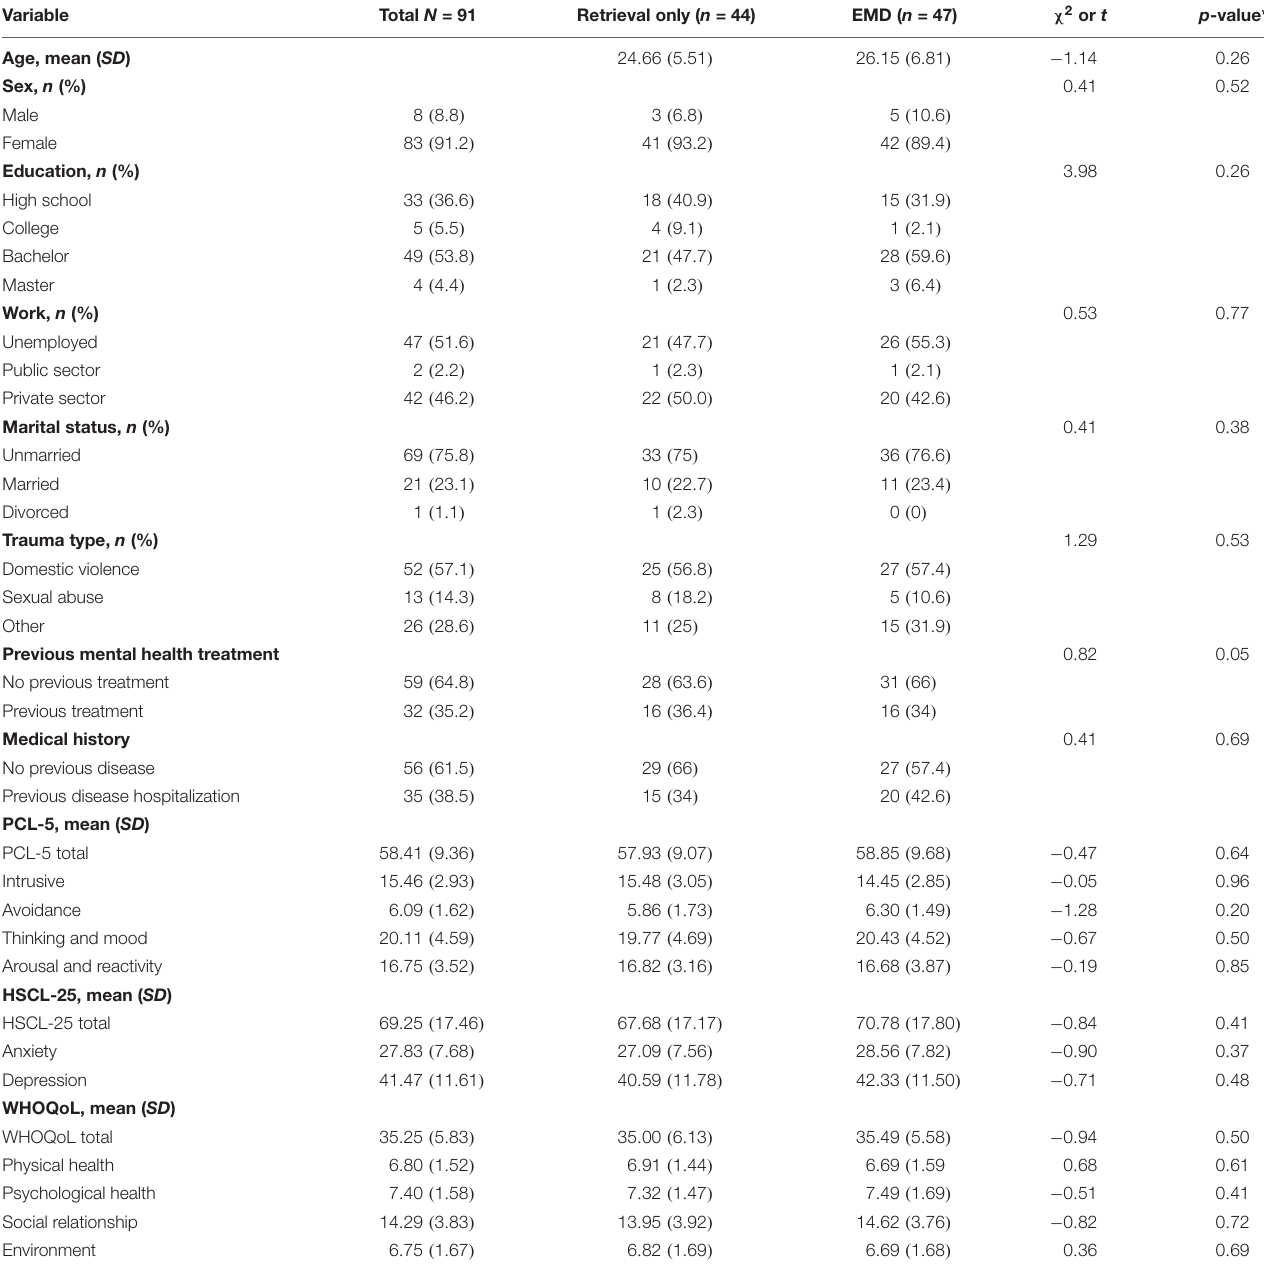
TABLE 1 | Baseline characteristics of